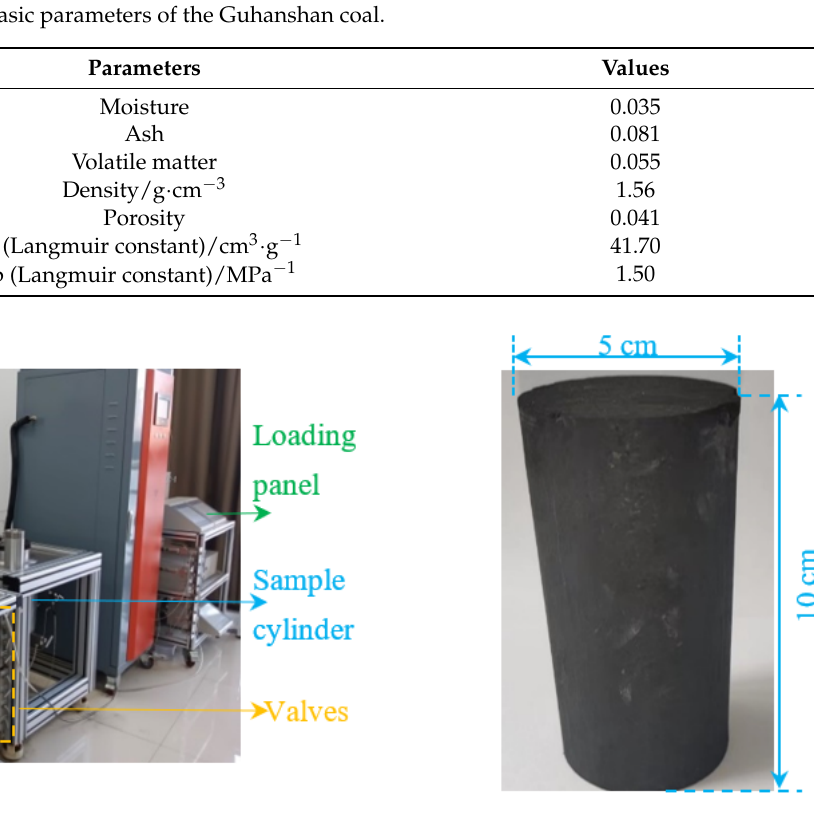
Table 1. Basic parameters of the Guhanshan coal.